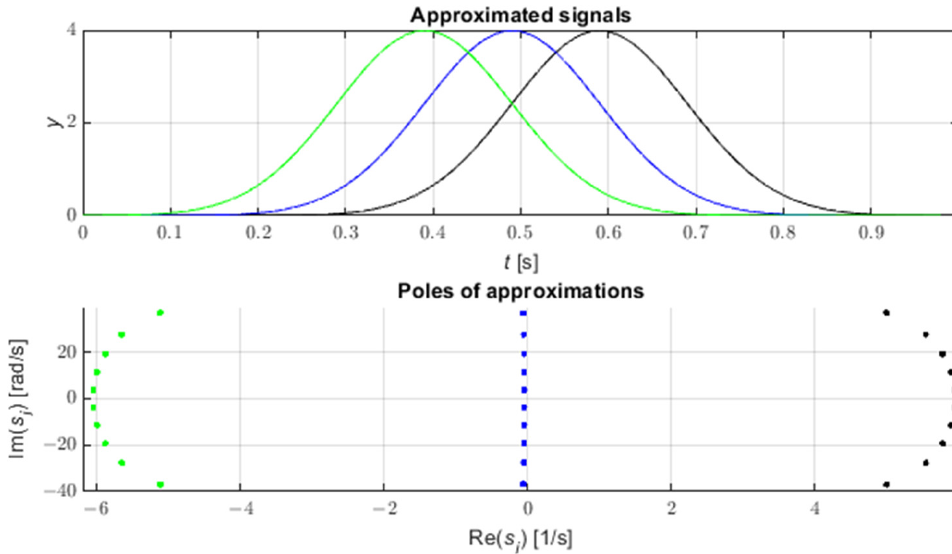
Figure 1. Gaussians and corresponding poles of approximations.